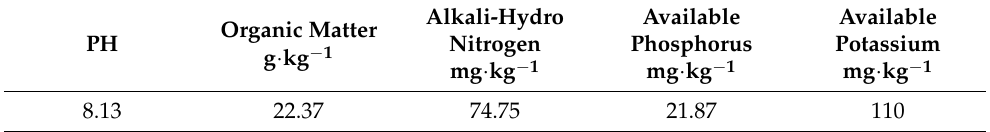
Table 1. The different fertilizer treatments.